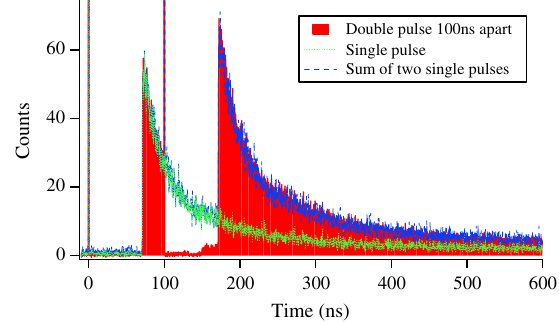
FIG. 5. The total probability of an afterpulse is the sum of the probabilities from each avalanche. Measurement in the lab using two laser pulses at time 0 and 100 ns (peaks at 400 000 counts, not shown) compared to the sum of the counts from two normalized single pulses.